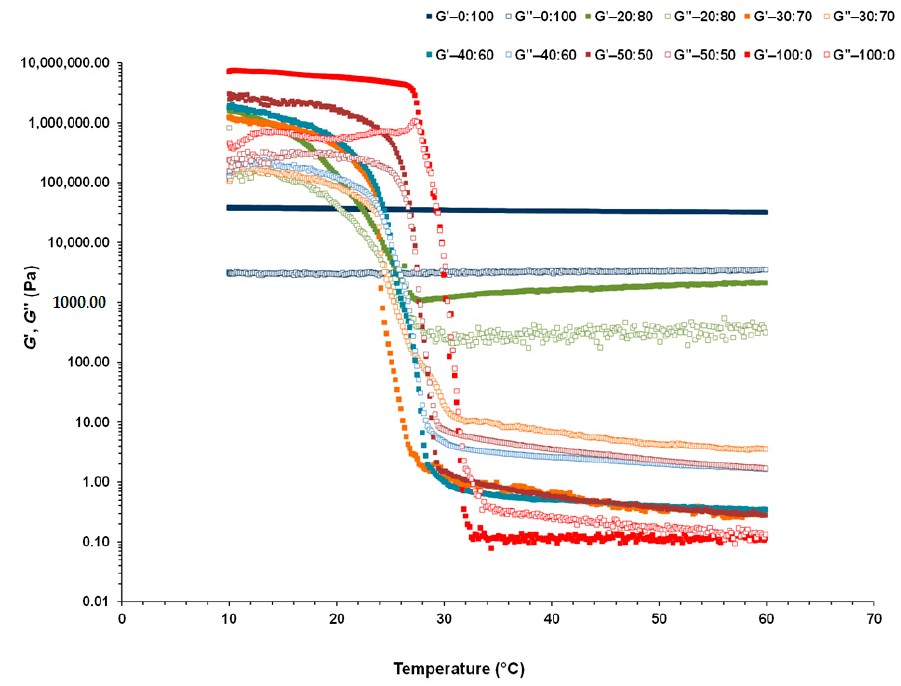
Figure 4. Storage modulus (G': filled squares) and loss modulus (G": open squares) as a function of temperature during heating between 10 and 60 °C for the different formulated CB:OG systems.